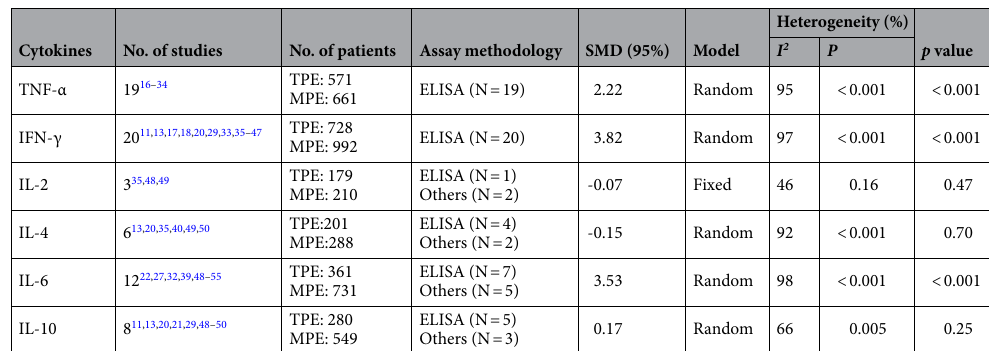
Table 1. Characteristics of the included original studies regarding the Th1/Th2 cytokine profiles for tuberculous and malignant pleural